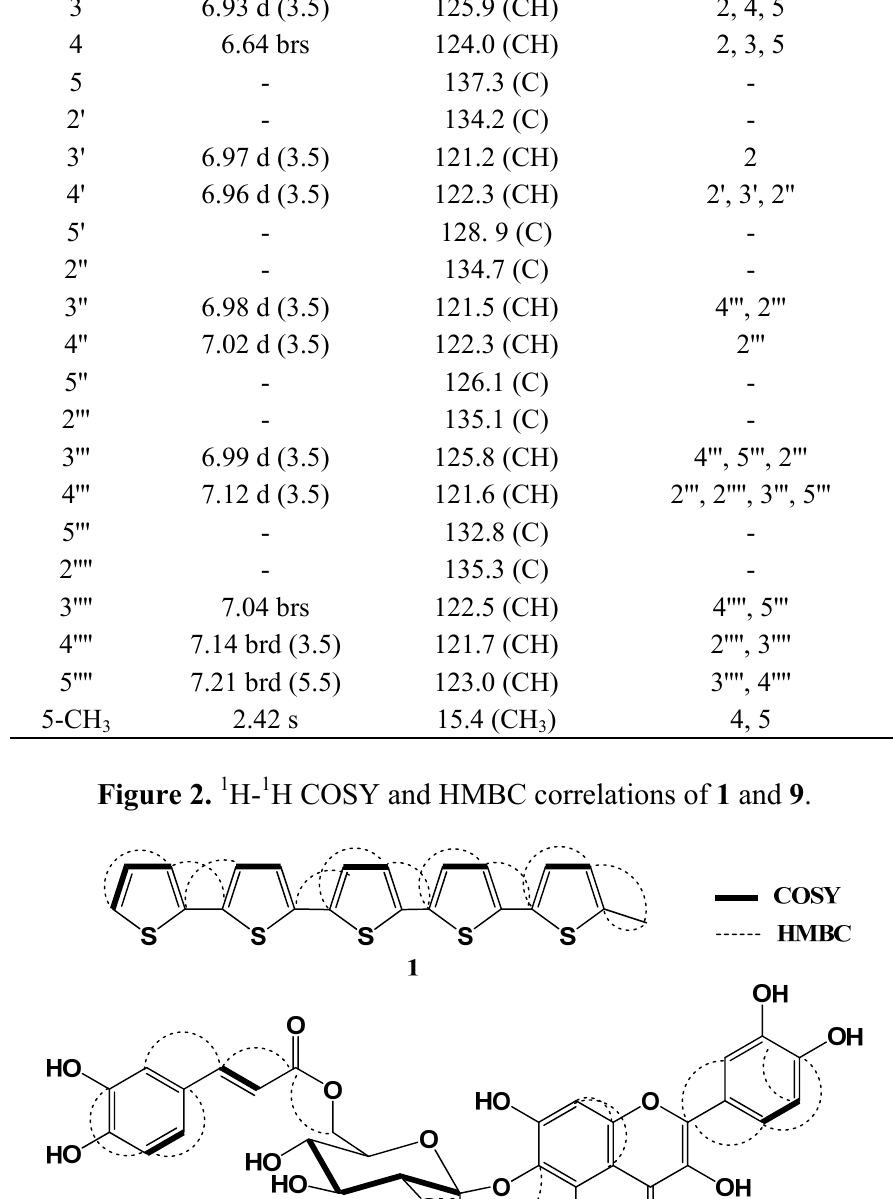
, 500 and 125 MHz). 3